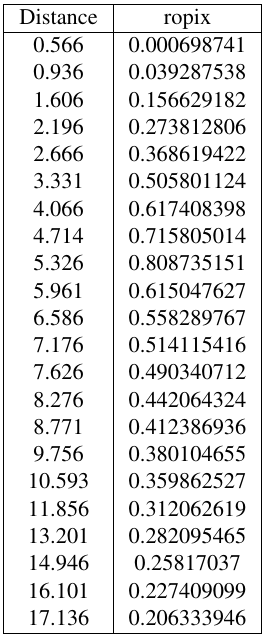
Table 4. Experiment Results of F